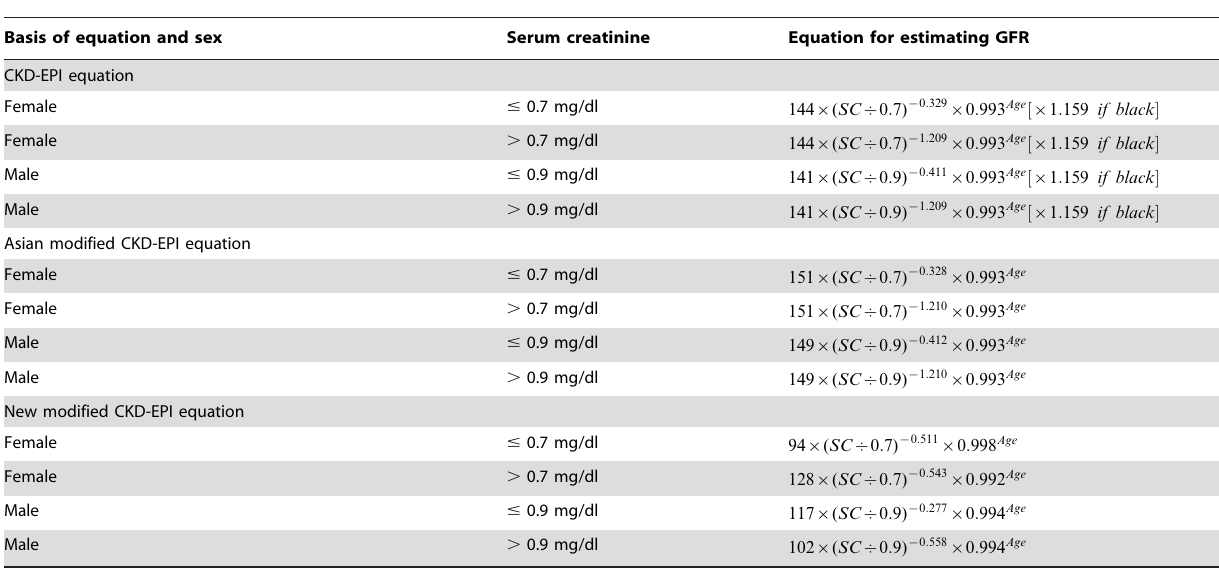
Table 1. CKD-EPI equation, asian modified CKD-EPI equation and the new equation.